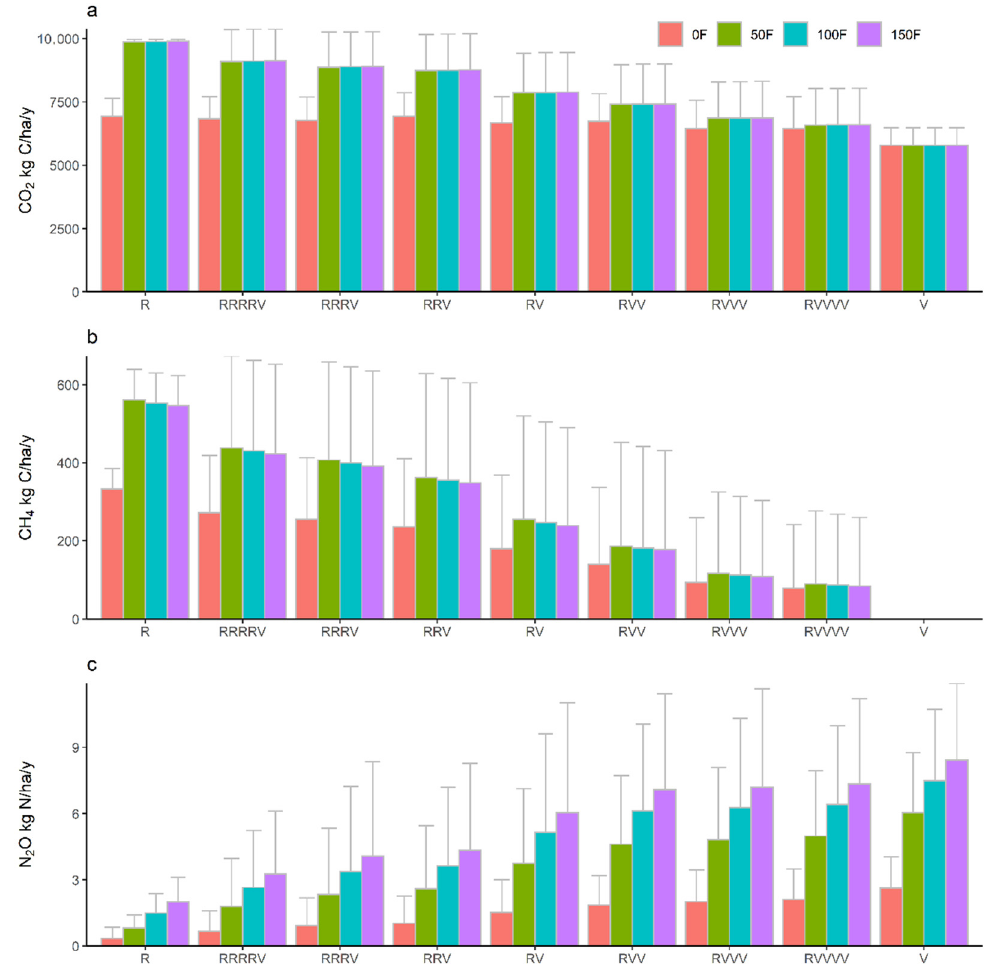
Figure 6. Average annual ( a ) CO 2 , ( b ) CH 4 and ( c ) N 2 O emissions ( d ) crop yield from the 40-year simulations as influenced by cropping systems and fertilizations. R and V represent a rice year or vegetable year, respectively; 0, 50, 100 and 150 F represent 0, 50, 100 and 150% of the conventional fertilization level in the experiment.